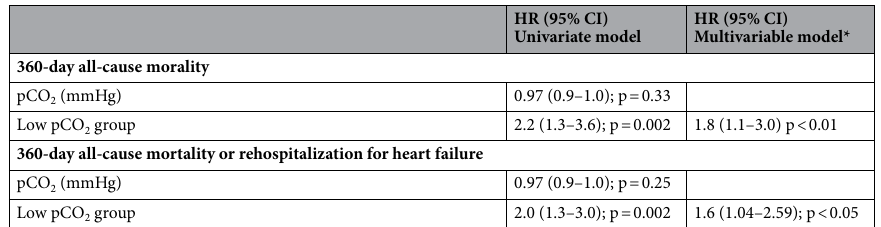
Table 4. One-year all-cause mortality and heart failure rehospitalizations risks in relation to pCO 2 level on admission. *Adjusted for: age, ejection fraction, systolic blood pressure at admission, haemoglobin. NTproBNP and serum